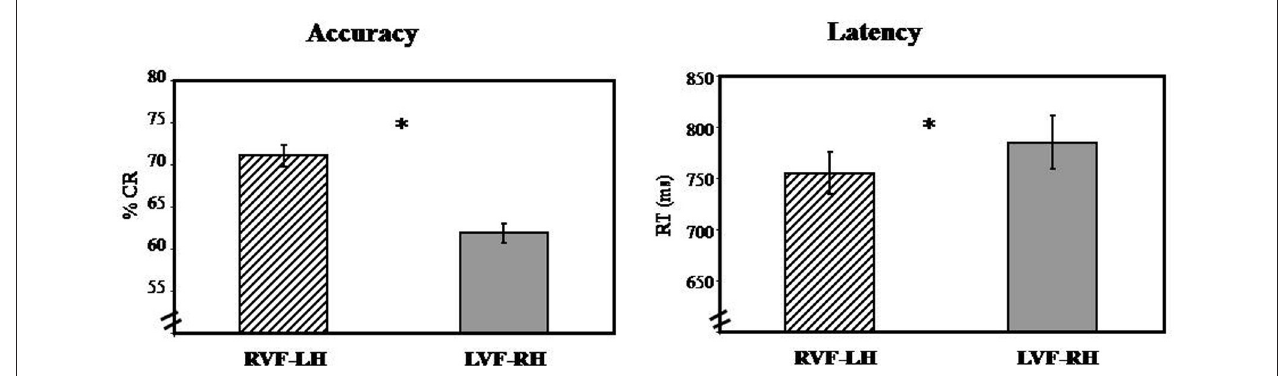
FIGURE 3 | Visual hemi-field effect: illustrates graphically results obtained in the first-step ANOVA analysis in terms of Accuracy (% CR) and response time (RT). Abbreviations: RVF, right visual hemi-field; LVF, left visual hemi-field; LH, left hemisphere; RH, right hemisphere. ∗ p < 0 . 05.